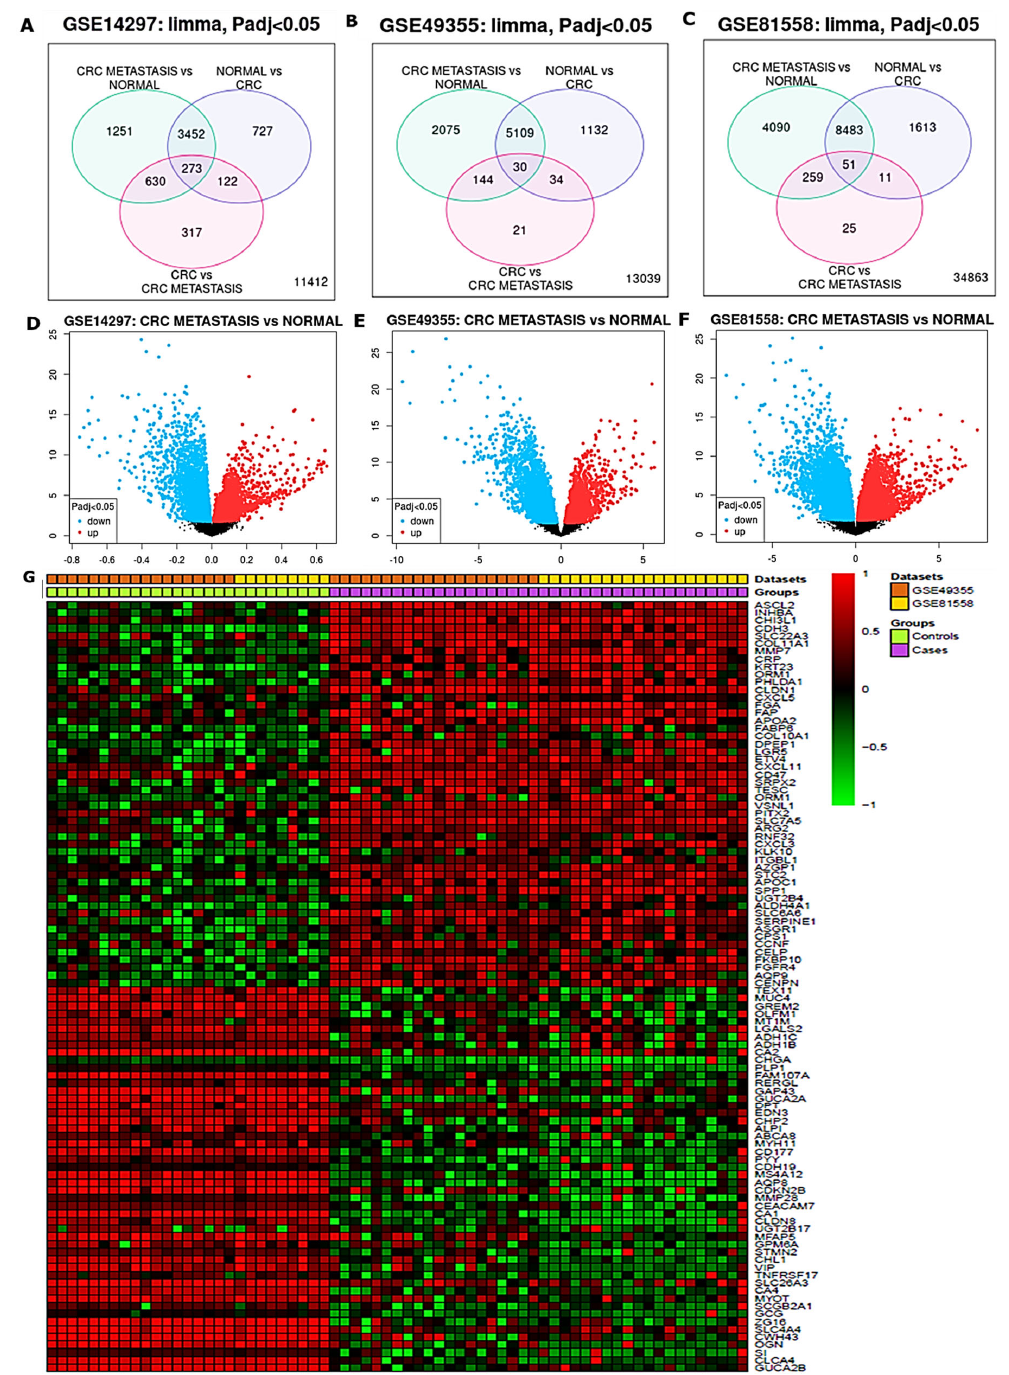
Figure 1. Differentially expressed genes (DEGs) in liver metastatic colon adenocarcinoma (CRC), primary CRC and normal sample, all obtained from GSE14297, GSE49355 and GSE81558 datasets. ( A – C ) Venn diagram showed 273, 30 and 51 overlapping upregulated genes from the above three databases, respectively. ( D – F ) volcano plots showing upregulated (red) and downregulated (blue) from metastatic samples as compared normal samples, respectively ( G ) shows the heatmap of overexpressed overlapping genes. with p ‐ value < 0.05 considered statistically significantly.